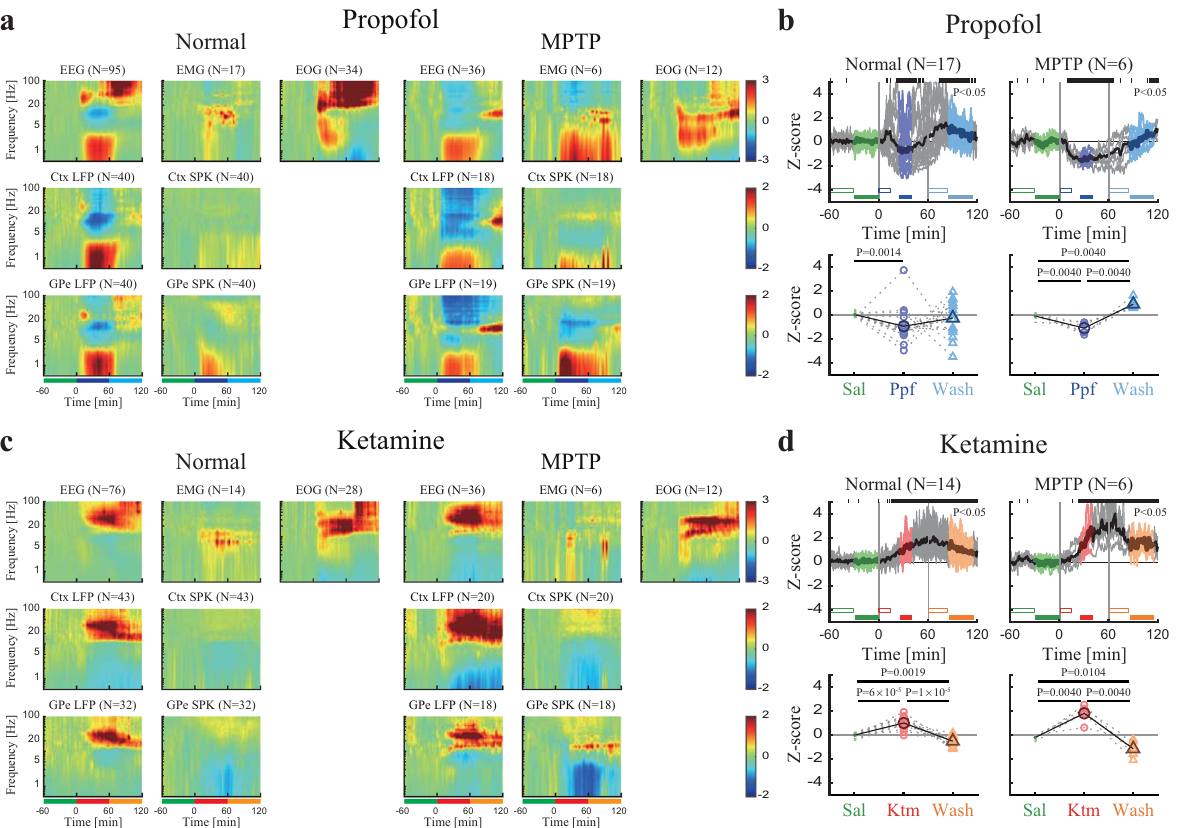
Fig. 2 Propofol and ketamine increase low- and high-frequency power, respectively, in polysomnography and cortico-basal ganglia neural activity. a The normalized power spectrograms of EEG/EMG/EOG (1 st row), Ctx LFP/SPK (2 nd row), and GPe LFP/SPK (3 rd row) during saline baseline, propofol sedation, saline washout before (left), and after (right) MPTP-treatment. The lower bar represents 1-h time periods of saline baseline (green), propofol sedation (blue), and saline washout (cyan). b Upper. The normalized high/low power difference (averaged through all spectrograms within one session) between spectral power at high-frequency (12 – 40 Hz) and low-frequency (0.5 – 4 Hz) domains before (left) and after MPTP-treatment (right). Top black horizontal bar represents a signi fi cant difference compared to saline ( p < 0.05, Kruskal – Wallis test). Lower. The change from baseline of the normalized high/low power difference during saline baseline (upper, green minus empty green), propofol sedation (upper, blue minus empty blue), saline washout (upper, cyan minus empty cyan) before (left), and after (right) MPTP-treatment. P -value is given, Kruskal – Wallis test. c , d Same conventions as a, b. during ketamine. Color represents saline baseline (green), ketamine sedation (red), and saline washout (orange). The number of sessions (b, d) and sites (a, c) is given for both monkeys in each subplot. Abbreviations as in Fig.